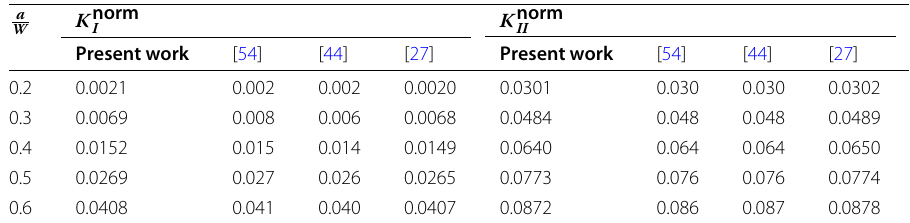
Table4 Normalized SIFs for slope crack, β = 30 ◦ and various a / W